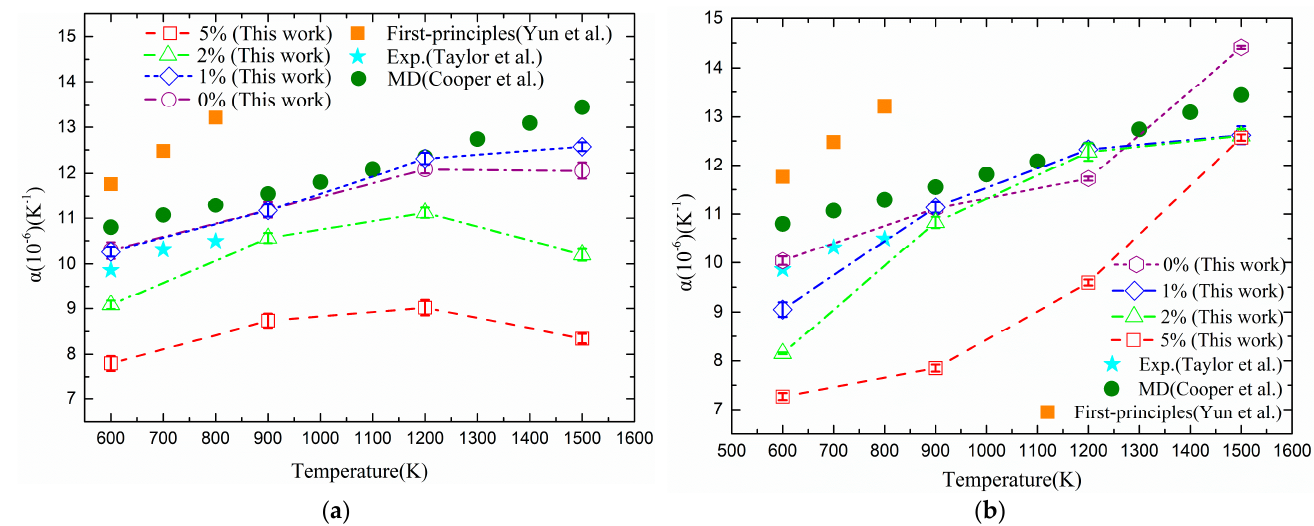
Figure 3. Thermal expansion coefficient for pure UO 2 and for defective UO 2 with different percentages of Frenkel defect ( a ), and antisites ( b ), as a function of temperature. For comparison, the experiment studies by Taylor et al. [27], the MD results by Cooper et al. [30] and the first-principles data by Yun et al. [31] are included in the figure.